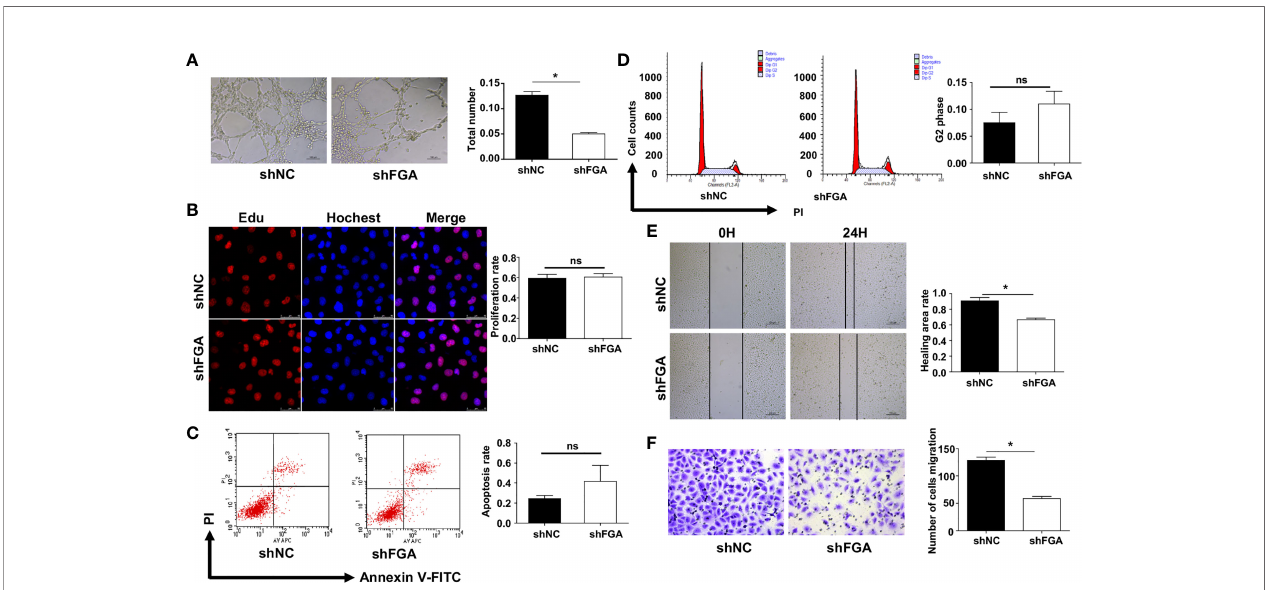
FIGURE 3 | Effect of the conditioned medium (CM) of EuESCs with FGA knockdown on HUVECs. (A) Tube formation assay. HUVECs were plated on Matrigel in the CM of EuESCs shNC and EuESCs shFGA cells and then were observed under microscope after incubating for 4h. (left) Representative images of tube, bar=200 m m. (right) Quantitative analysis of total tube number. (B) Edu assay showing the proliferation of HUEVCs treated with CM from EuESCs shNC and EuESCs shFGA cells for 24h. (C, D) Flow cytometry analysis showing that apoptosis rate (C) and cell cycle (D) of HUEVCs treated with CM from EuESCs shNC and EuESCs shFGA cells for 24h. (E, F) Scratch assay (E) and transwell assay (F) were conducted to assess migration ability of HUEVCs treated with CM from EuESCs shNC and EuESCs shFGA cells for 24h . * P <0.05, ns, not signi fi cant, P ≥